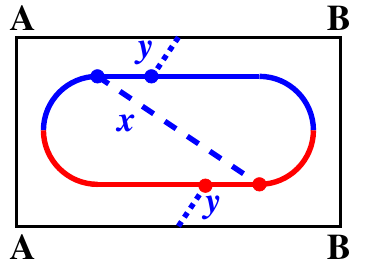
Figure 20 . The A3 diagram drawn on a cylinder, as in section 4.3 of ref.